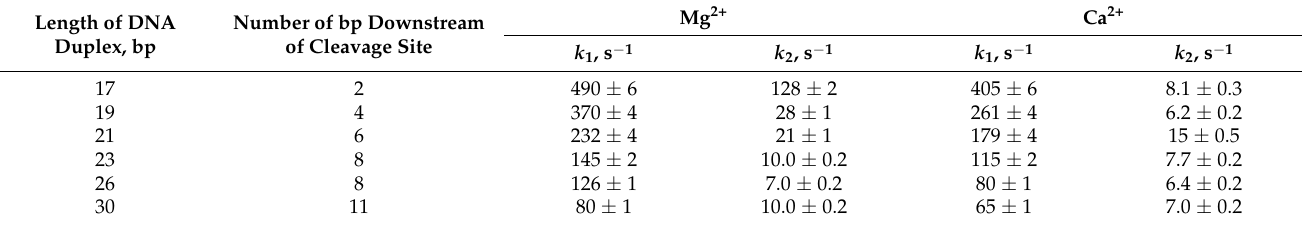
Table 3. Observed rate constants for the formation of Nt.BspD6I complexes with DNA duplexes of various lengths. Length of DNA Number of bp Downstream Duplex, bp of Cleavage